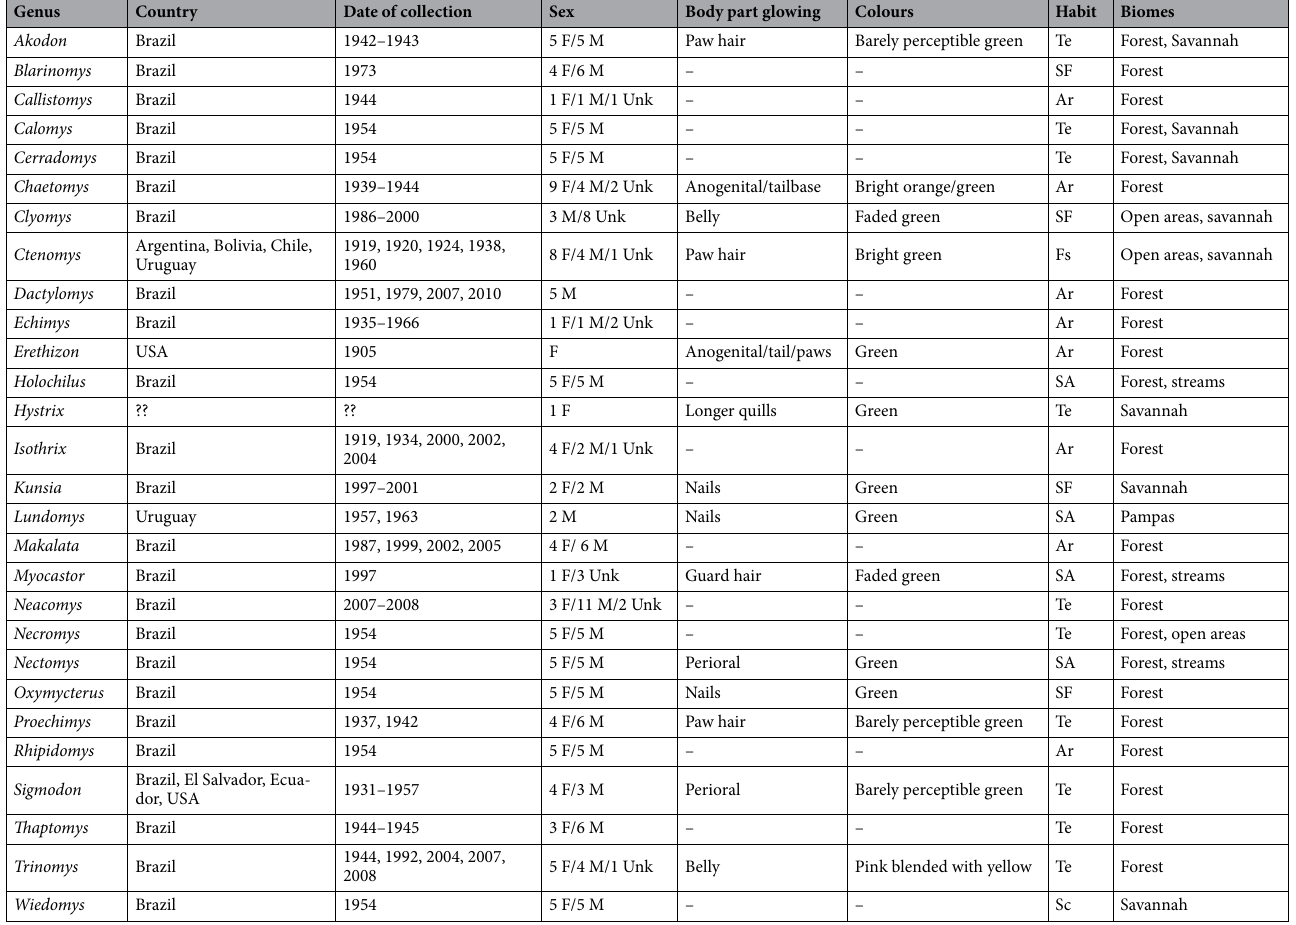
Table 1. List of genera illuminated with a handheld LED UV flashlight 395 nm, and relevant information on the surveyed specimens. Habit and biomes follow 17 . Te - terrestrial; SF - semifossorial; Ar - arboreal; Fs